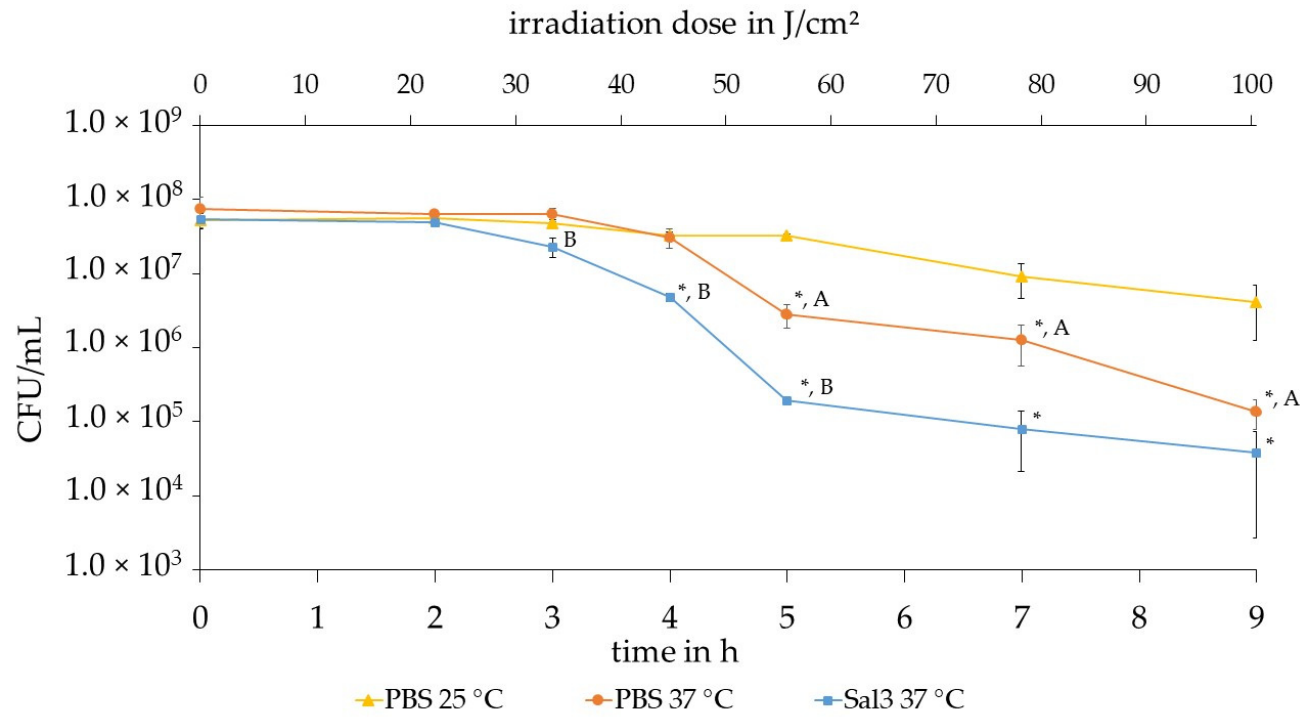
Figure 4. Comparison of the results of experiments with 405 nm irradiated S. carnosus at different temperatures and in different solutions. The curves represent triangle: 25 °C in PBS, circle: 37 °C in PBS and square: 37 °C in Sal3 with the mean deviation as errors. * represents a significant difference to the corresponding control, A represents a significant difference between PBS 25 °C and PBS 37 °C and B represents a significant difference between PBS 37 °C and Sal3 37 °C.